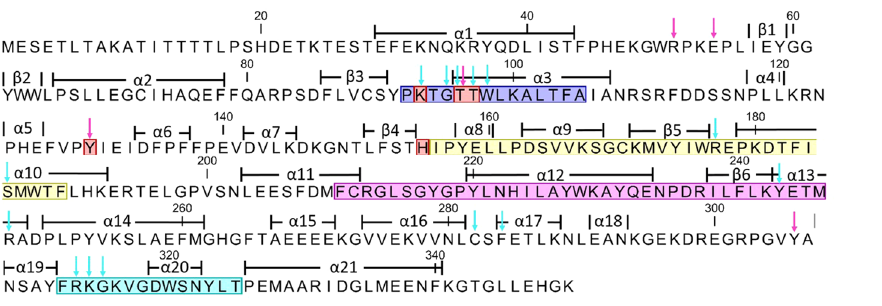
Figure 2. AtSOT18 amino acid sequence. Conserved regions as defined by 8 (region I: blue; region II: yellow; region III: magenta: region IV: cyan), catalytic residues (red), PAP binding residues (cyan arrows), sinigrin binding residues (magenta